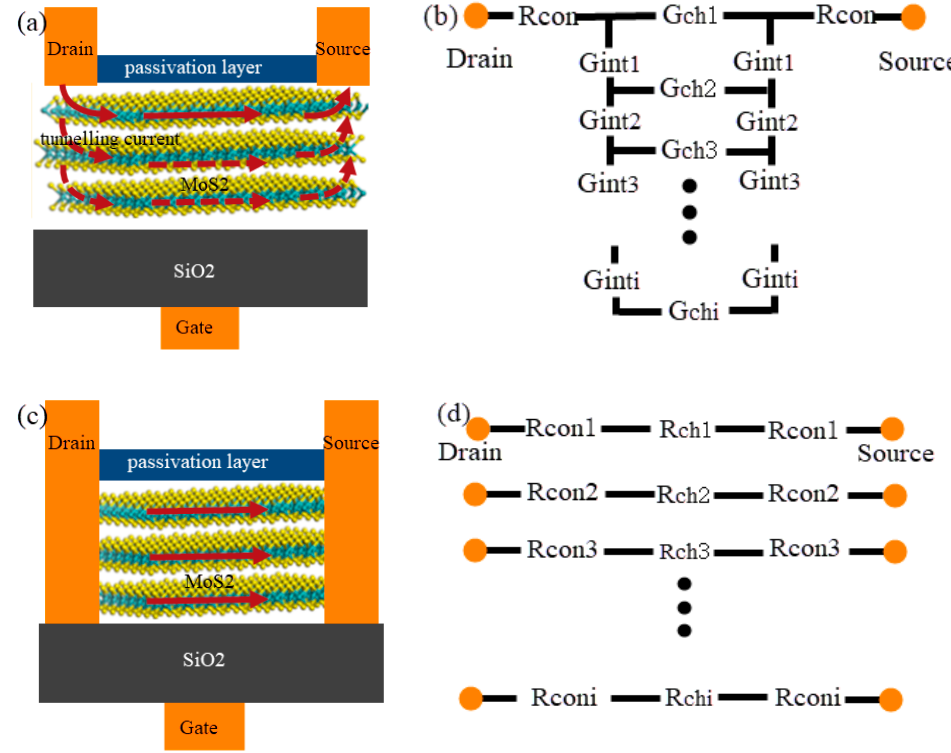
Figure 7. ( a ) current flow in top-contact structure MoS 2 FET; ( b ) channel resistance model of top-contacted structure MoS 2 FET; ( c ) current flow in edge-contacted structure MoS 2 FET; ( d ) channel resistance model of edge-contacted structure MoS 2 FET.